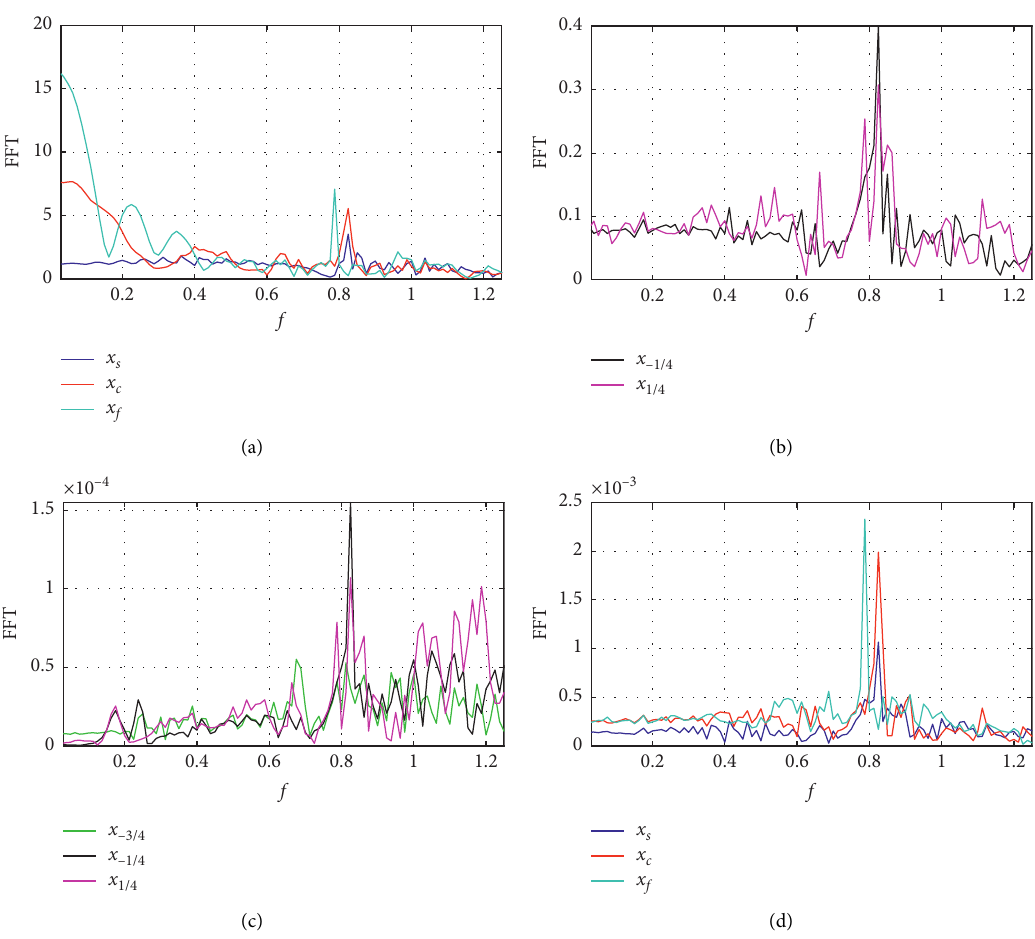
Figure 5: (Color on line) the spatial frequency spectrum of electromagnetic oscillations shown in Figure 4 for various points along the charge path, having highest spectral peaks at k s ∼ 0 . 82. Such oscillations correspond to optical eigenmodes of PCr excited by the moving charged particle for components (a) E x , (b) E y , (c) H x , and (d) H z , for values v